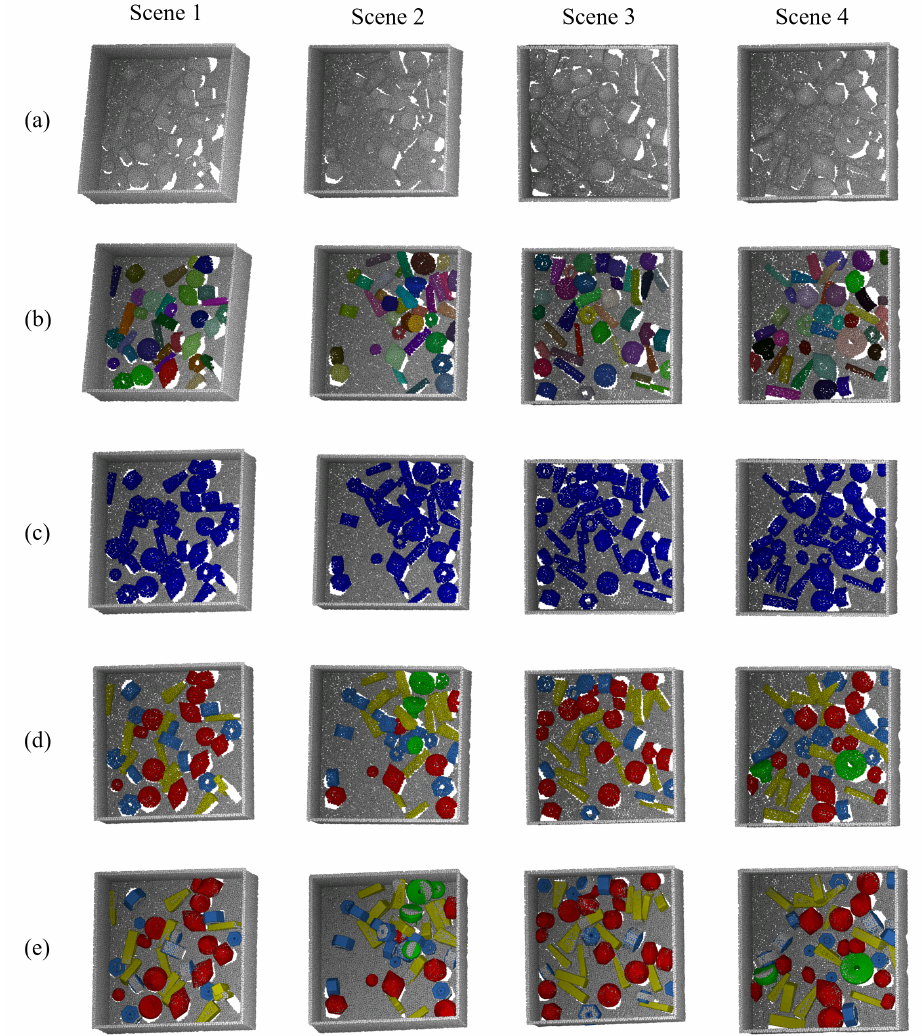
Figure 7. The visualization for predicted results of four scenes on our test set, ( a ) input point cloud; ( b ) instance segmentation; ( c ) foreground segmentation; ( d ) template segmentation; ( e ) 6D pose estimation and parameter values prediction. The foreground segmentation, instance segmentation, and template segmentation shown in the figure above are the segmentation results on the raw point cloud. To visualize 6D pose estimation and parameter values prediction, we reconstruct the part objects’ models from the template segmentation results and the parameter values prediction results, and the models are transformed in the scene by the 6D pose estimation results to overlap on the raw point